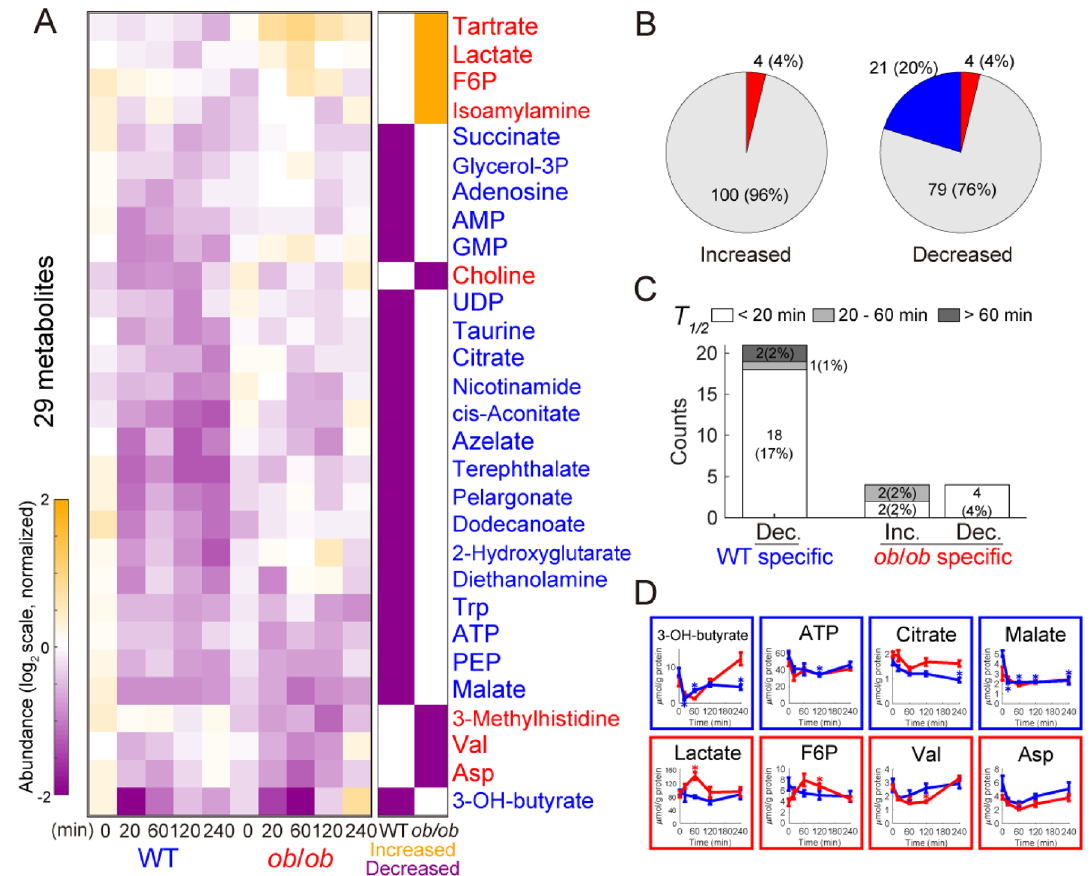
Figure 2. Identification of glucose-responsive metabolites. ( A ) Left: Heat map of the time courses of 29 glucose-responsive metabolites from the skeletal muscles of WT and ob / ob mice following oral glucose administration (n = 5 mice per genotype at all time points). To investigate the changes from fasting state, two time courses for each metabolite were divided by the geometric mean of the values of fasted WT mice and ob / ob mice (0 min) and then log 2 -transformed. Metabolites were ordered by hierarchical clustering using Euclidean distance and Ward’s method. Right: The bars in the heat map are colored according to the extent of glucose responsiveness, meaning the change from fasting state (0 min) in WT and ob / ob mice. Metabolites that showed an absolute log 2 fold change ≥ 0.585 (2 0.585 = 1.5) and an FDR-adjusted p value (q value) ≤ 0.1 at any time point (20, 60, 120, 240 min) were defined as glucose-responsive: increased (orange), decreased (purple), or were unchanged (white). To define an increase or decrease in time courses with changes in both directions at different times, we used the direction of change compared to time 0 at the earliest time point that showed a significant change. Metabolites written in blue text indicate glucose-responsive metabolites specific to WT mice; red text, specific to ob / ob mice. ( B ) Increased and decreased metabolites in the skeletal muscles of WT mice and ob / ob mice. Blue, WT specific; red, ob / ob specific; gray, not glucose-responsive metabolites either in WT mice or in ob / ob mice. The number of each type of glucose-responsive metabolites and their percentages of the total quantified metabolites are shown. ( C ) Rapid, intermediate, and slow responses in increased metabolites specific to WT mice, decreased metabolites specific to WT mice, increased metabolites specific to ob / ob mice, and decreased metabolites specific to ob / ob mice. ( D ) Graphs showing the metabolites with responses that were specific to WT mice (blue boxes) and specific to ob / ob mice (red boxes). Blue lines are the responses of the WT mice and red lines are the responses of the ob / ob mice. Data are shown as the mean and standard error of the mean (SEM) of five mice per genotype. *q value < 0.1 and absolute log 2 fold change > 0.585. Metabolites are abbreviated as follows: F6P, fructose 6-phosphate; PEP, phosphoenolpyruvate; Glycerol-3P, glycerol 3-phosphate; 3-OH-butyrate,